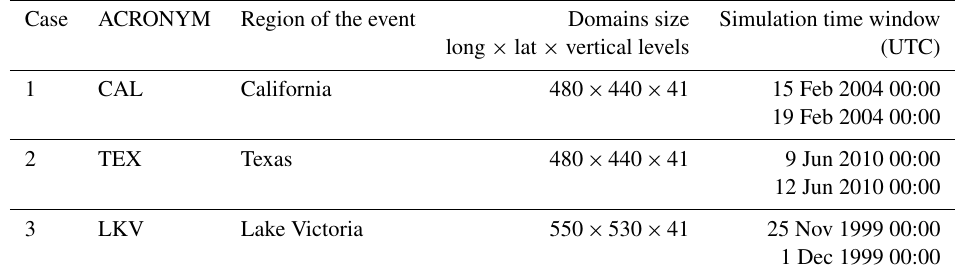
Figure 3. Domains tested: (a) California (CAL), (b) Texas (TEX), (c) Lake Victoria (LKV). For CAL (a) and LKV (b) the black square shows the 3km simulation domains nested in the 12km domain in the figure. For the TEX case (b) the 3km domain simulation is fed directly with the ERA-Interim reanalysis fields. Table 2. List of abbreviations and description of the test cases with corresponding 3km domain sizes and simulation period.